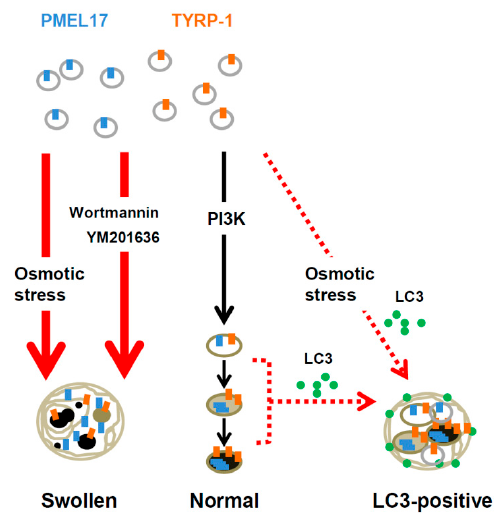
Figure 1. Osmotic stress disturbs normal melanosome formation by inhibiting the PI3K pathway. PI3K inhibitors, such as Wortmannin and YM201636, cause hypopigmentation in a similar manner to osmotic stress. Osmotic stress also induces the formation of LC3-positive melanosomes, but the possible involvement of these melanosomes in pigmentation remains